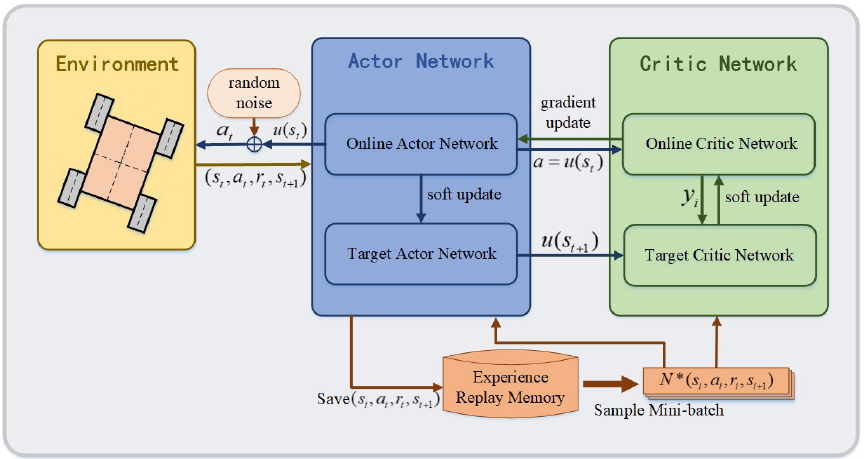
Figure 3. Framework of the DDPG